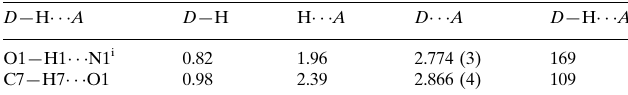
Hydrogen-bond geometry (A˚ , (cid:1)